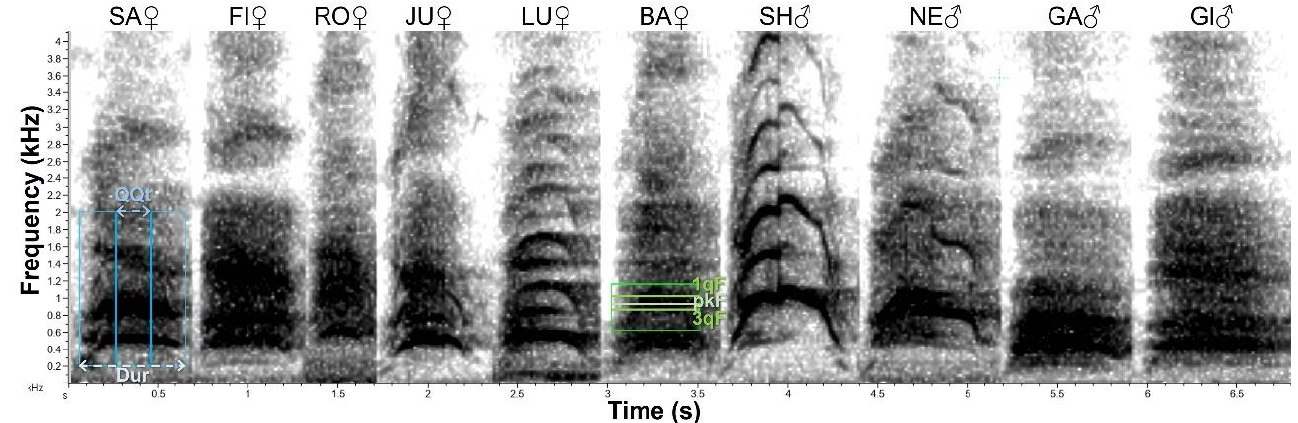
Figure 4. Roar-barks of captive maned wolves. The first box (blue) exemplified in SA shows the entire selection (200 – 2000 Hz), in which the Total Duration ( “ Dur ” in the image ) and InterQuartile Duration ( “ QQt ” ) are measured. The second box (green) exemplified in BA shows the selection of the second frequency band, in which the 1 st Frequency Quartile ( “ 1qF ” ), the Peak Frequency ( “ pkF ” ), and the 3 rd Frequency Quartile ( “ 3qF ” ) are measured. Spectrogram made in Raven Pro. 1.6.